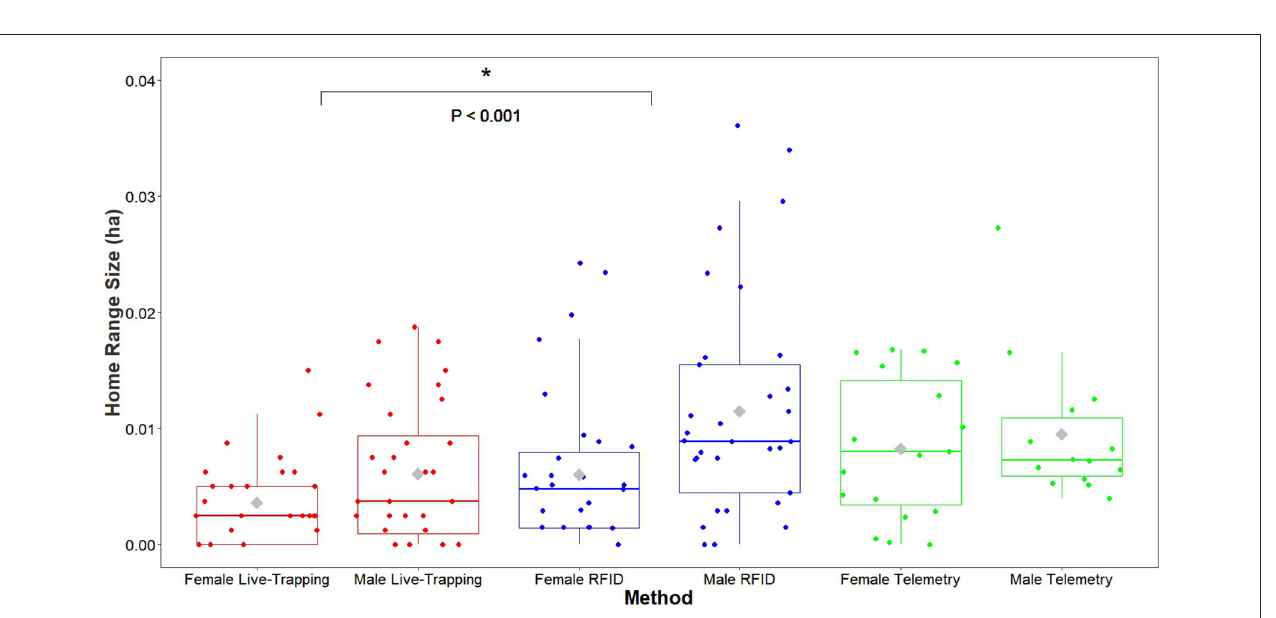
FIGURE 5 | Home range size estimates (minimum convex polygons) of adult prairie voles estimated using our automated RFID system were significantly larger than those estimated with live-trapping. Females and males were combined in these models, so P -values refer to the difference in home range estimates between methods for all adult male and female voles. * P <